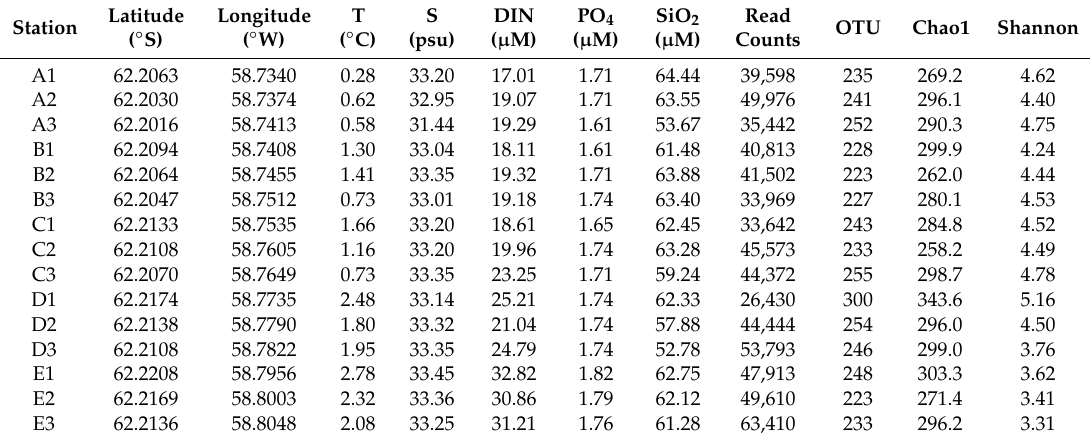
Table 1. Information of sampling locations, physicochemical properties, number of reads, operational taxonomic unit (OTU), richness (Chao1), and diversity (Shannon).